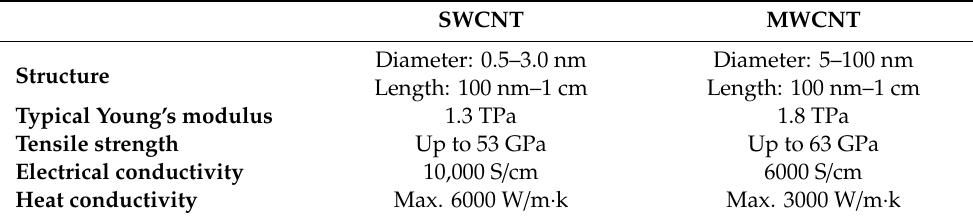
Table 1. Di ff erences between SWCNTs and